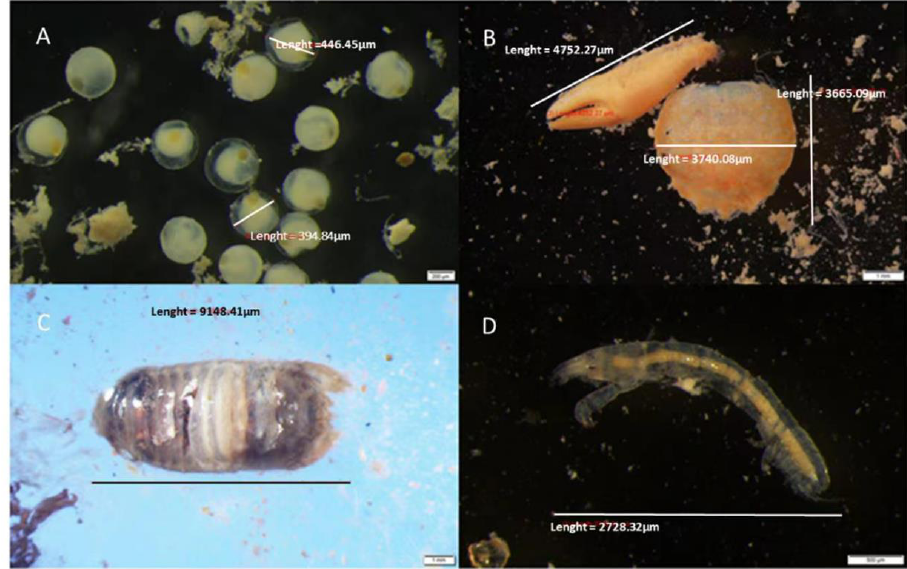
Figure 3. Prey items isolated from feces of S. scriba : ( A ) unidentified eggs, ( B ) carapace and claws of Pisidia sp., ( C ) isopod from family Sphaeromatidae and ( D ) Tanais dulongii.